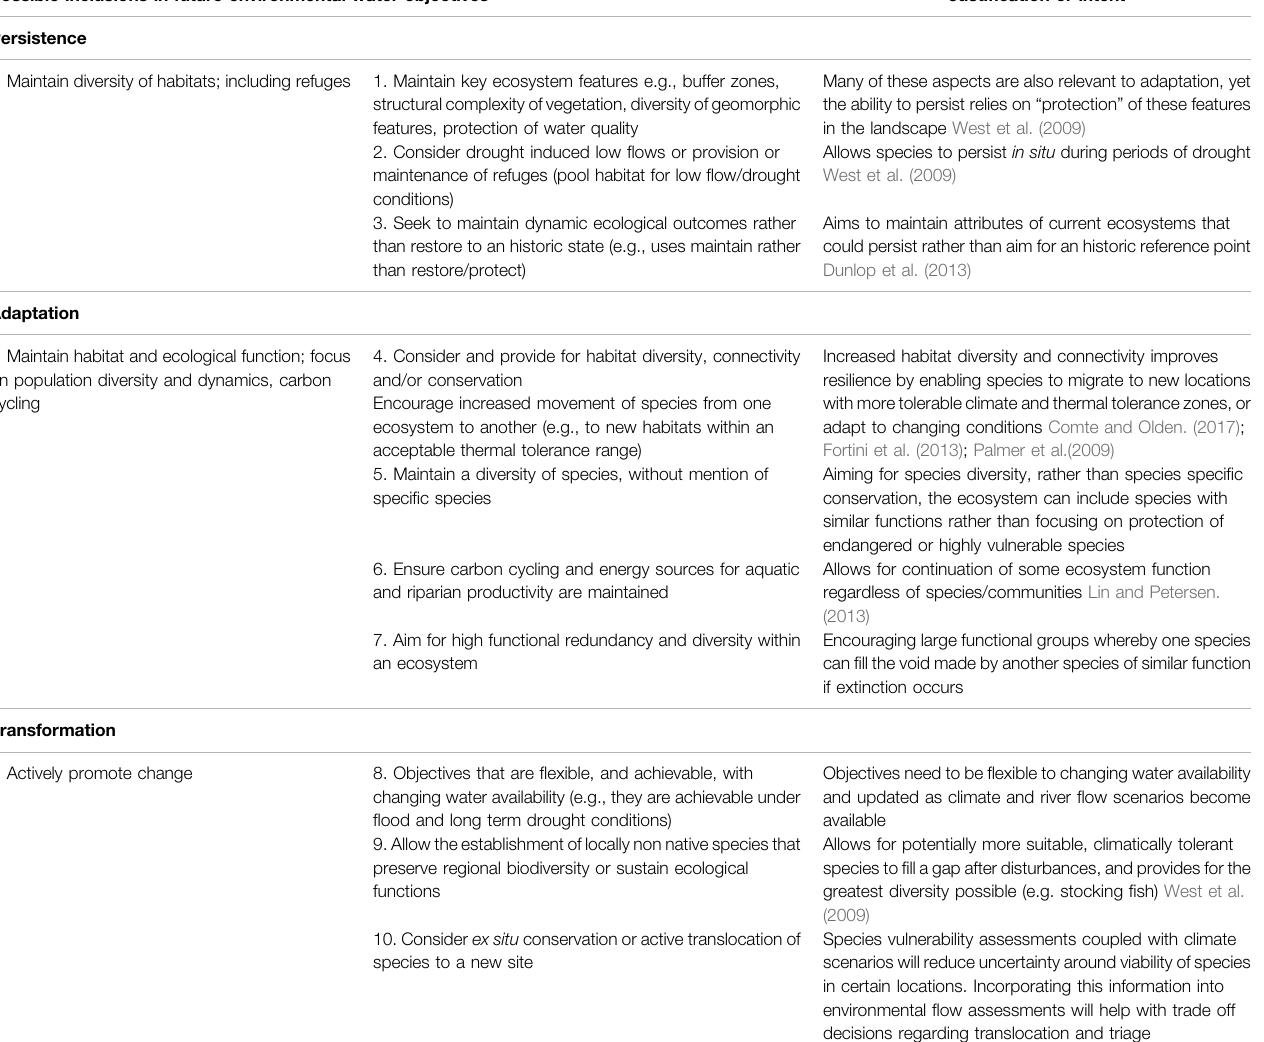
TABLE 1 | Example of ecological objectives that include consideration of climate impacts and